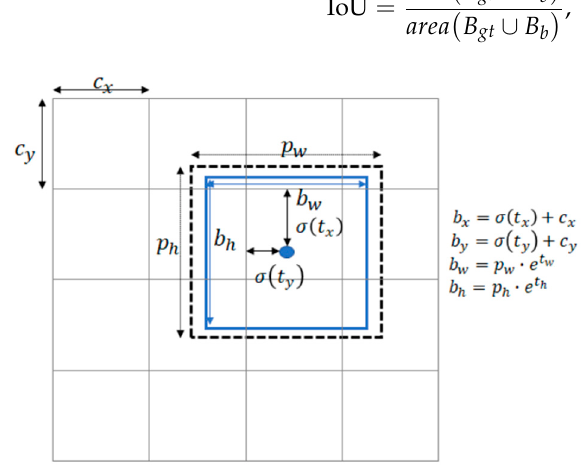
Figure 5. Prediction of bounding